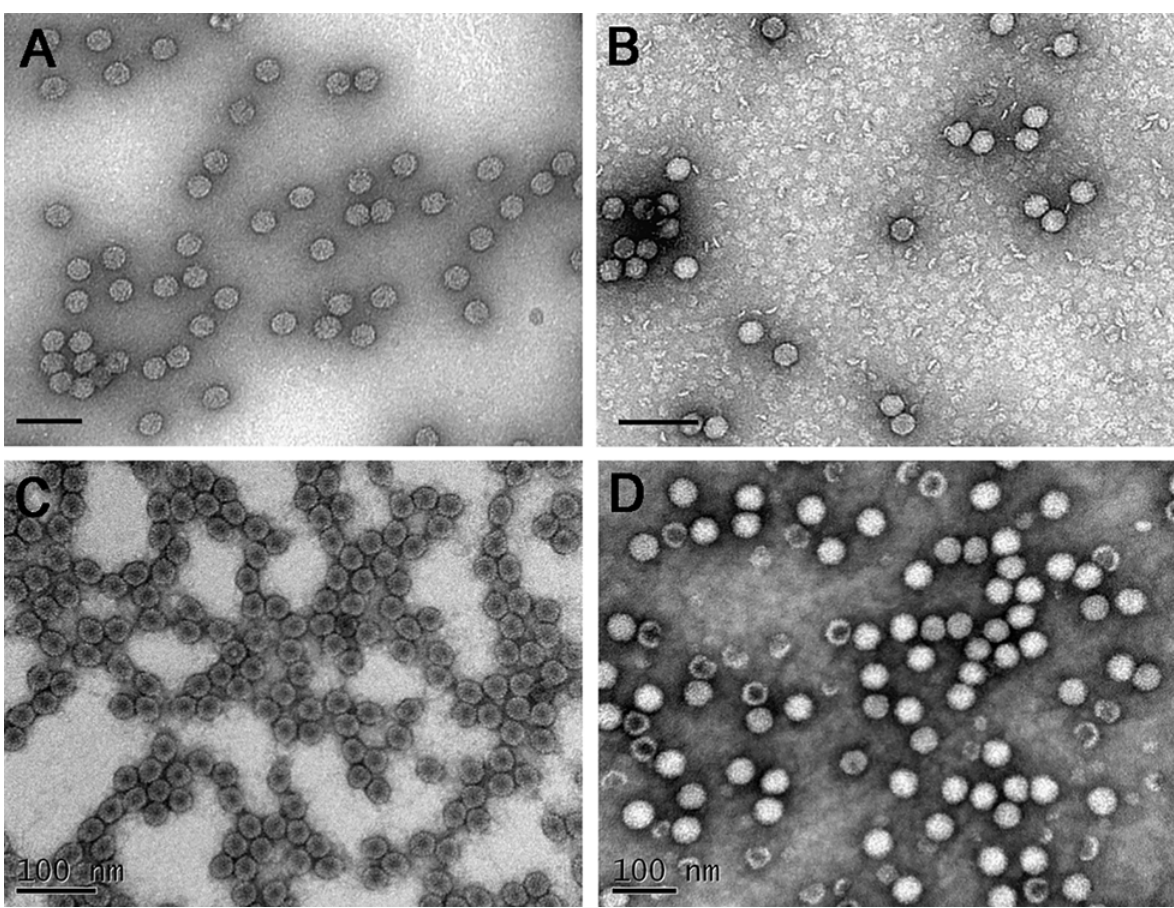
Fig 1. Transmission electron micrographs of virions CaMV (A), EMCV (B), BMV (C), BMMV (D). Samples were stained with 2% uranyl acetate. Bars, 100 nm.